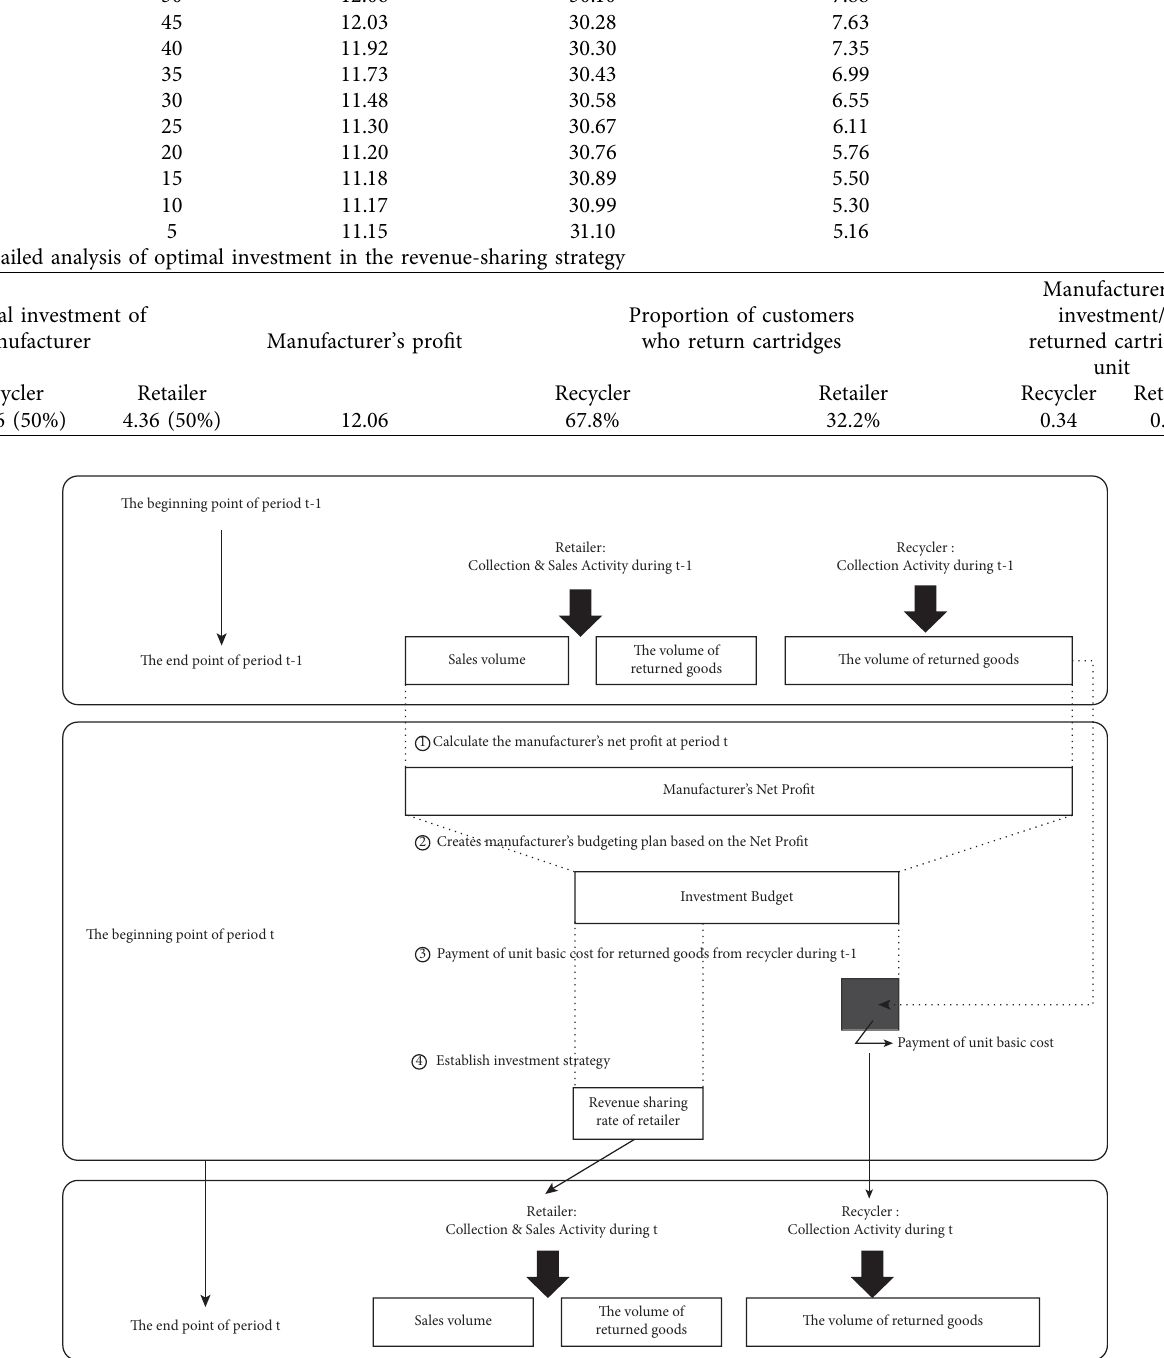
Figure 7: The procedure for direct payment per unit returned